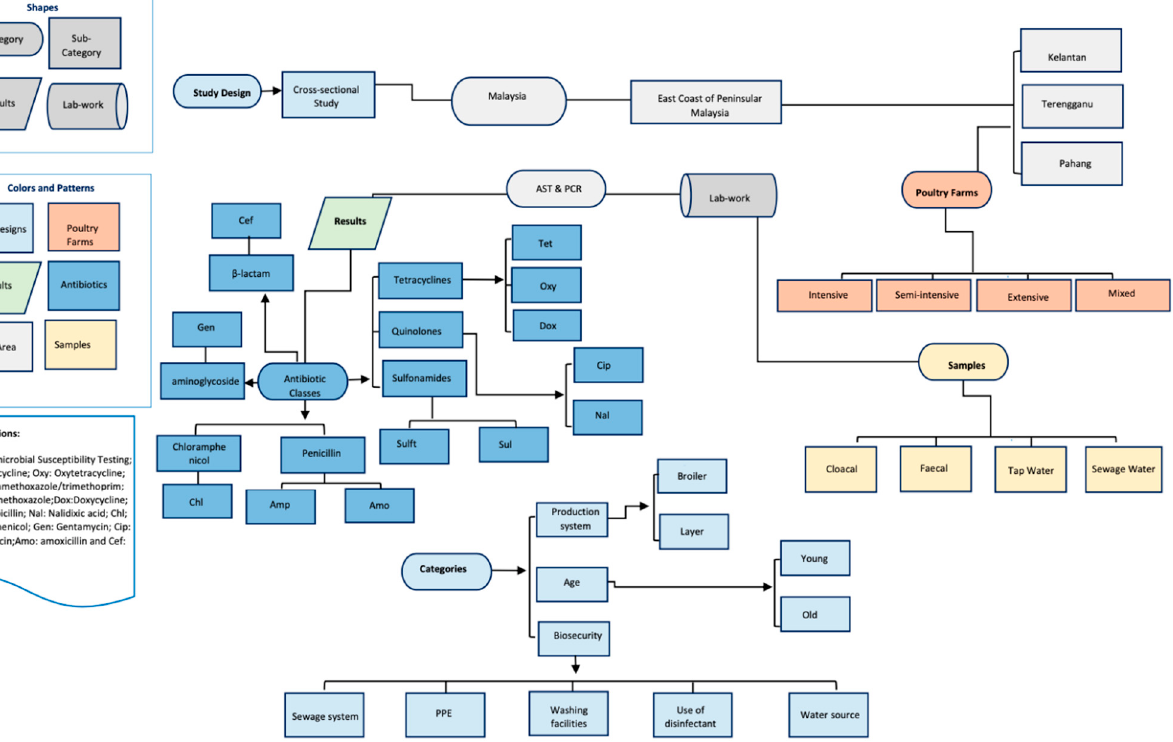
Figure 5. Diagrammatic representation of the study design.